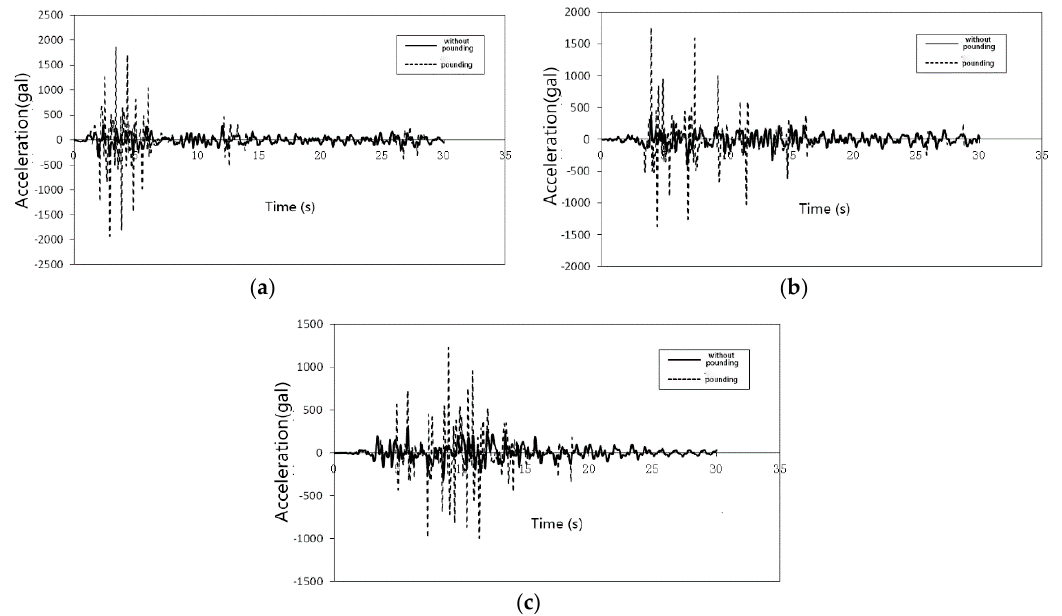
Figure 16. Structural acceleration under different earthquakes (model A). ( a ) El Centro earthquake; ( b ) Taft earthquake; and, ( c ) Artificial excitation.